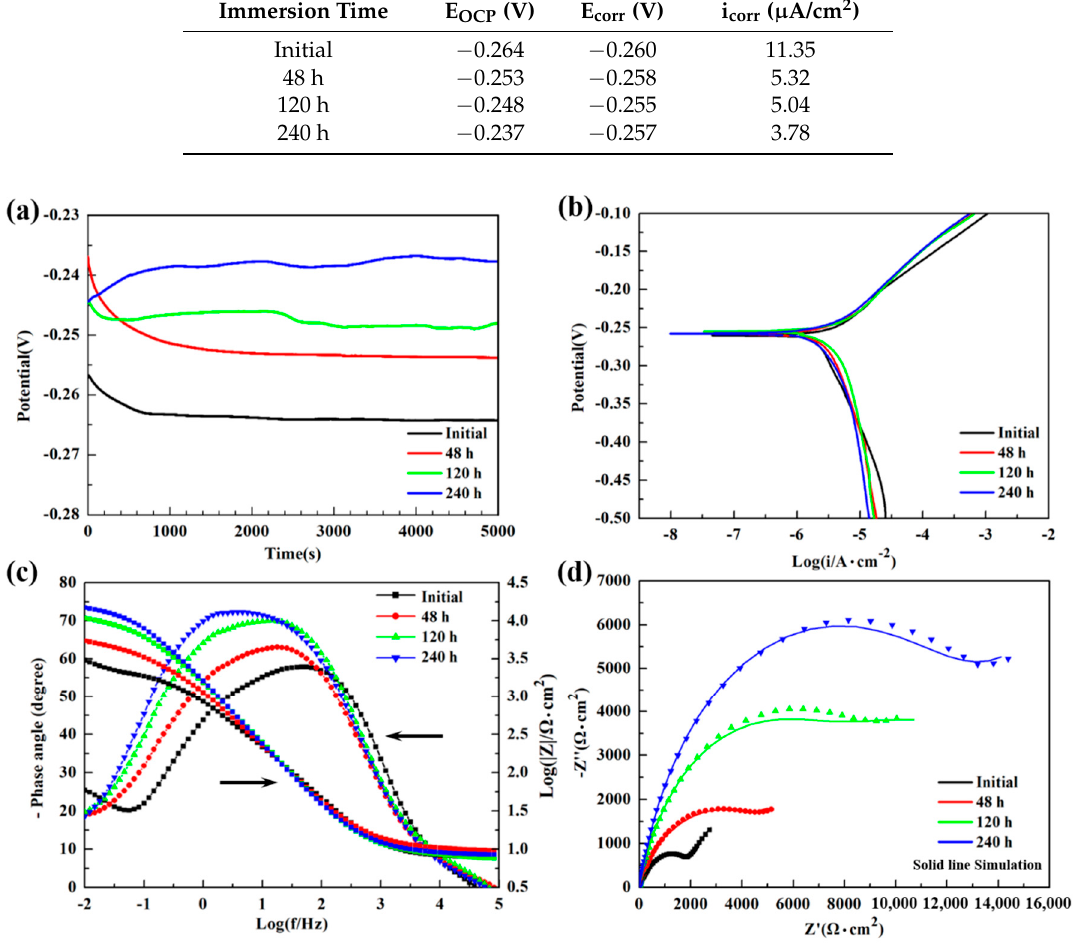
Figure 5. Electrochemical properties of NAB alloy with different immersion time in 3.5 wt % NaCl solution: ( a ) open circuit potential; ( b ) potentiodynamic polarization curves; ( c ) Bode plots with impedance and phase angle; ( d ) Nyquist plots.